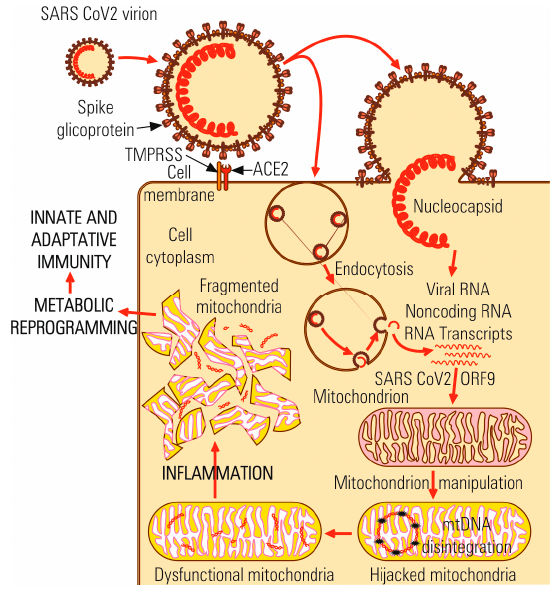
Figure 4. Hijacking mitochondrial metabolic processes in Covid-19 infection.